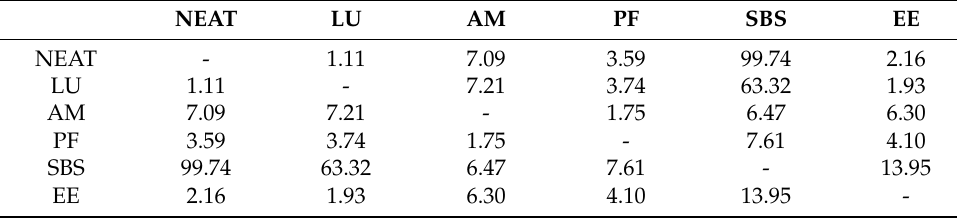
Table 9. Effect sizes dynamic modulus at the temperature of 4.4 ◦